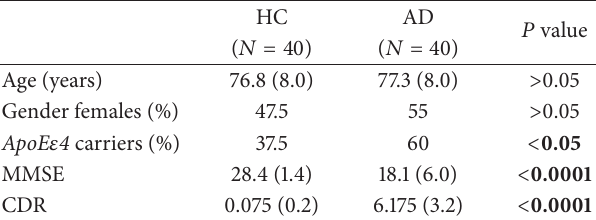
Table 3: AIBL cohort demographics for individuals analysed for erythrocyte Cu